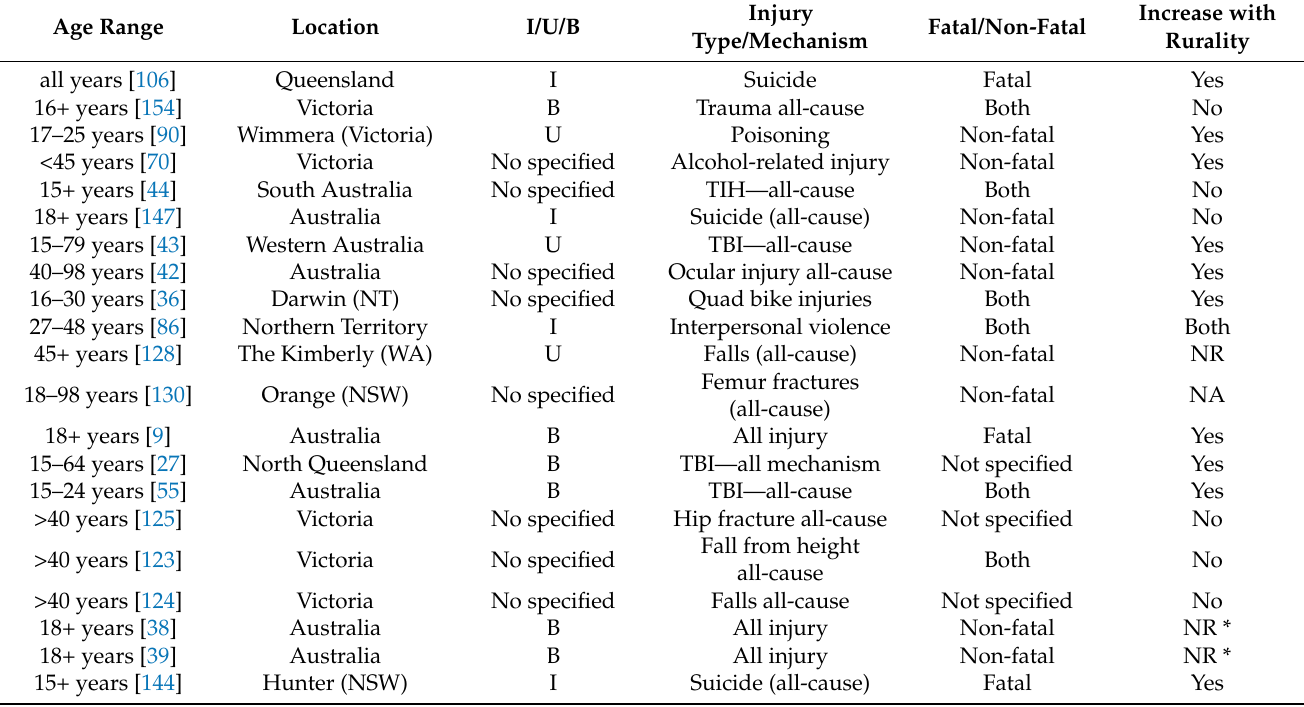
Table 6. Adult Rural Injury Epidemiology.